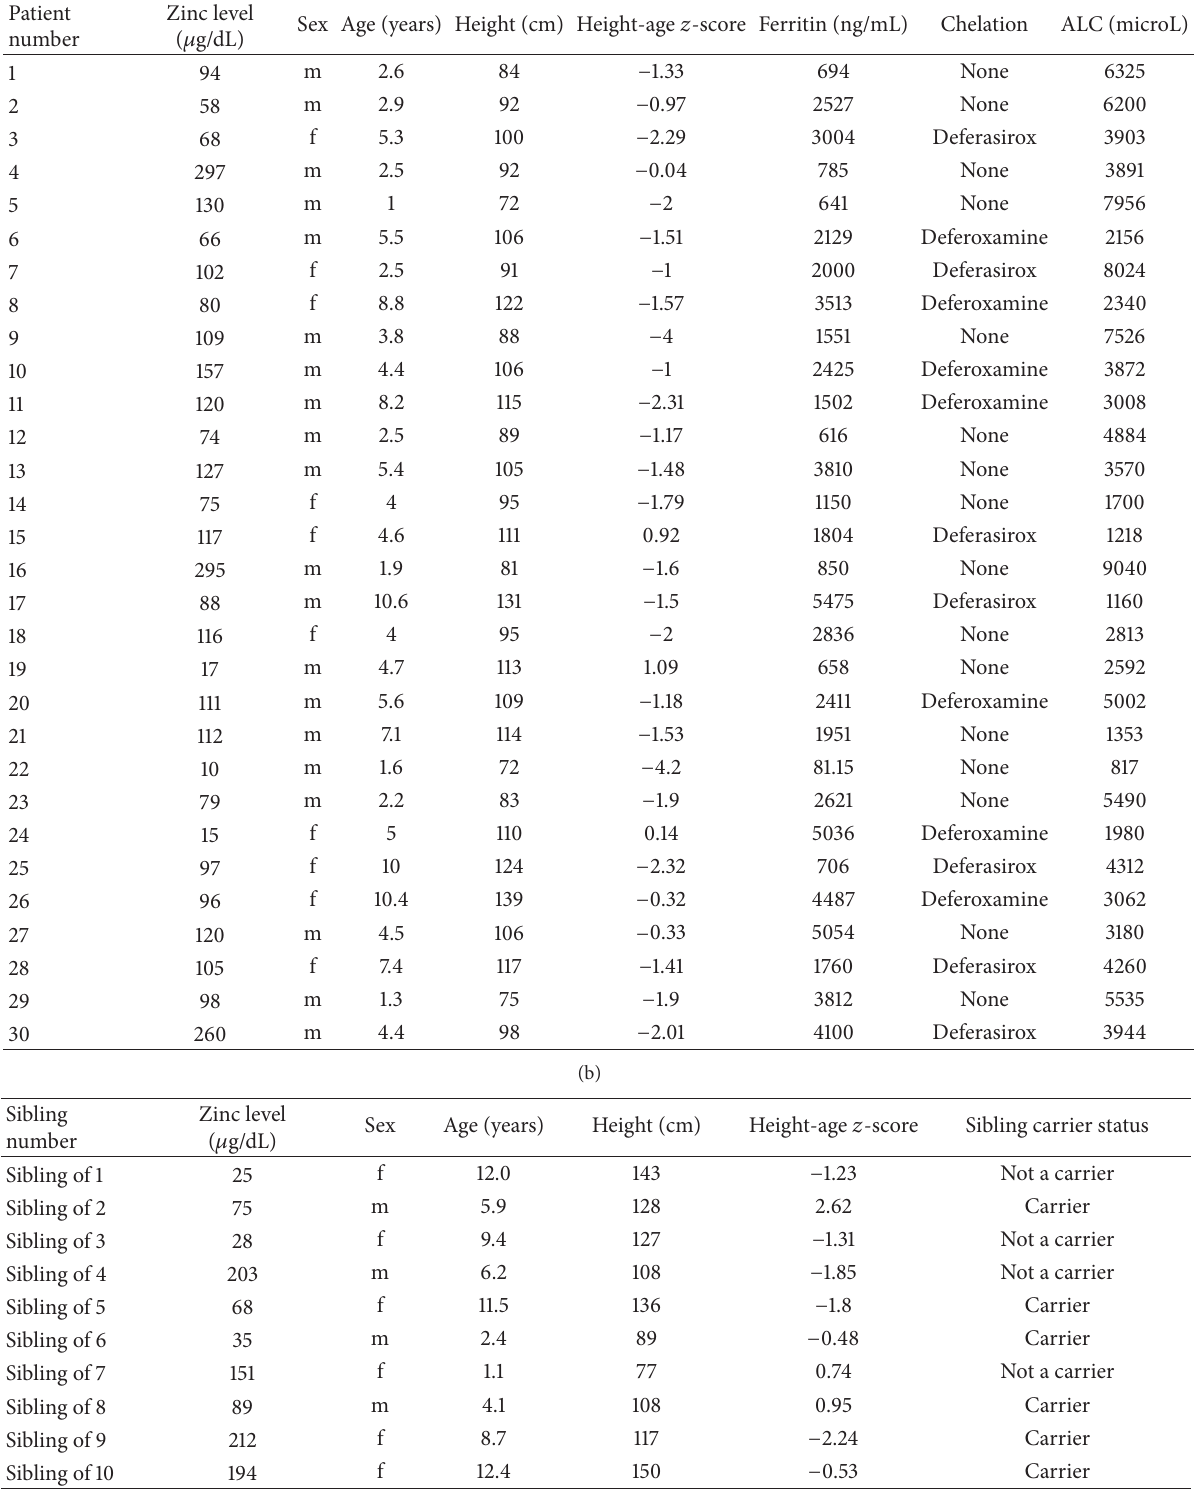
Table 1: (a) A collective table for the data of the patients: zinc level in 𝜇 g/dL, sex (m: male, f: female), age (in years), height (in cm), height-age 𝑧 -score, ferritin level (in ng/mL), chelation type, and ALC (in microL). (b) A collective table for the data of the patients: zinc level in 𝜇 g/dL, sex (m: male, f: female), age (in years), height (in cm), and height-age 𝑧